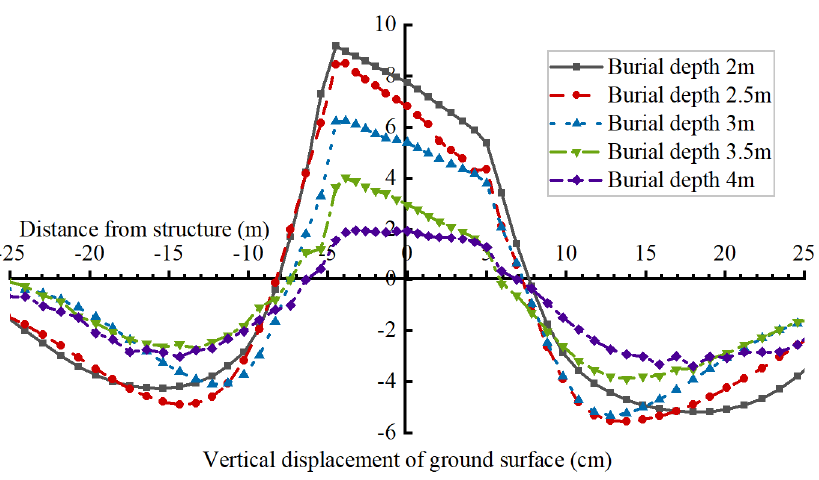
Figure 14. Residual vertical displacement of the ground surface under five burial depth condi- tions.